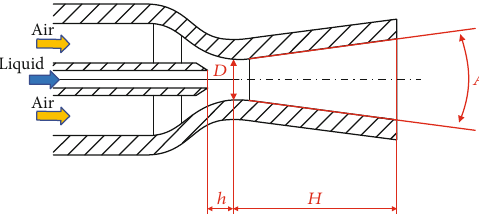
Figure 5: Schematic of expansion exit adopted in the